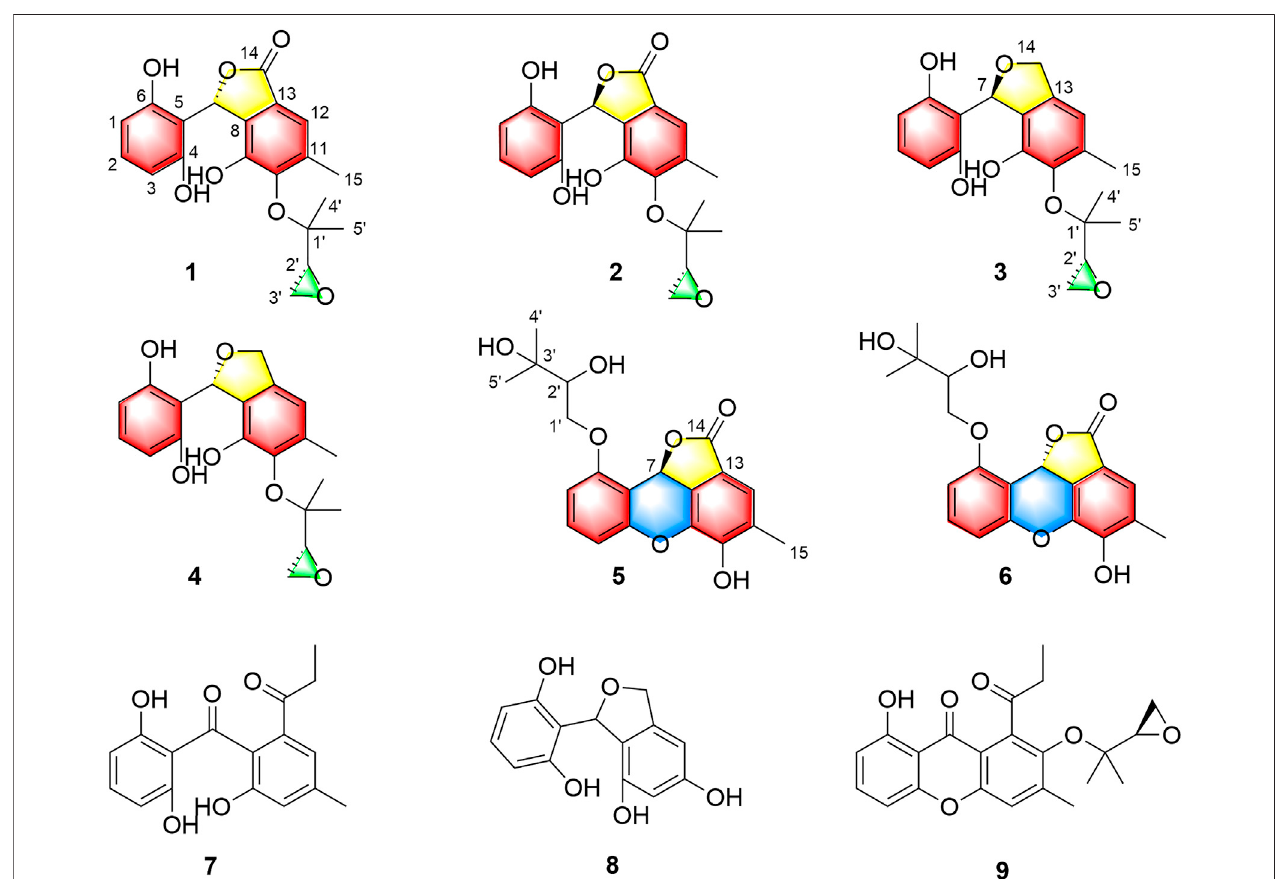
FIGURE 1 | Structures of compounds 1-9